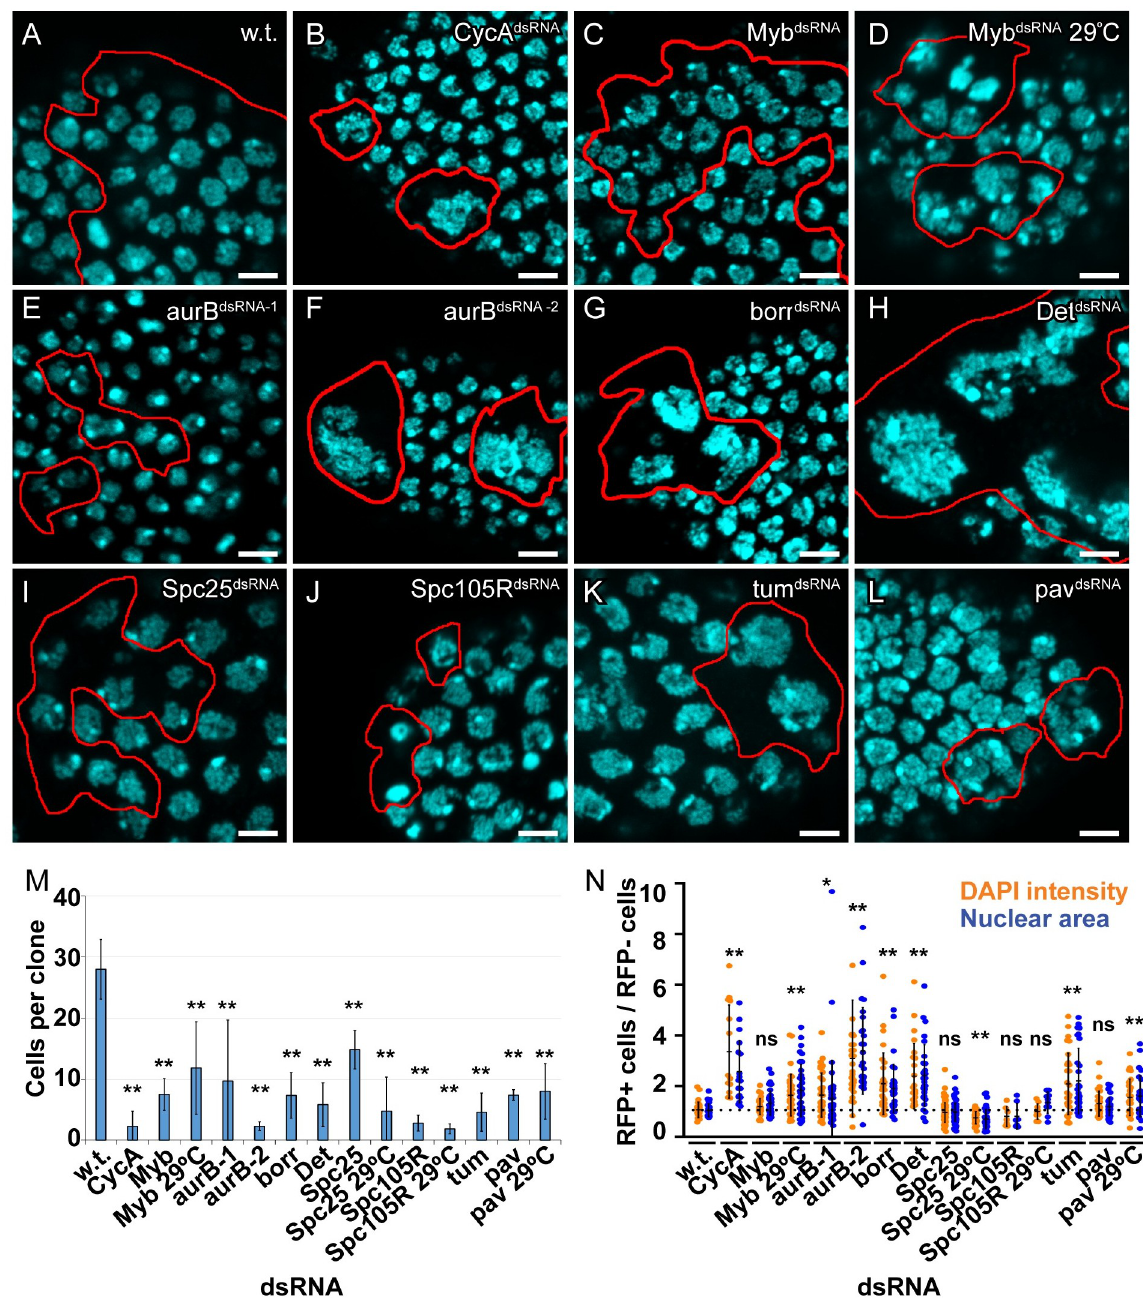
Fig 6. Knockdown of a CycA—Myb—AurB network induces endoreplication in ovarian follicle cells. (A-L) Clonal knockdown in follicle cells. FLP-On of GAL4 expression was induced by heat treatment of adult females of genotype hsp70-FLP , Act > cd2 > Gal4 , UAS-mRFP and the indicated UAS-dsRNA . mRFP positive clones were analyzed in stage 6 egg chambers three days later by labeling with DAPI and measuring nuclear size and total fluorescence intensity (DNA content). Red outlines in A-L indicate clone boundaries. (M) Quantification of number of cells per clone. RFP expressing cells were counted from at least four independent clones. More clones were counted in samples with fewer cells / clone (mean and S.D. for N � 4 clones, �� —p < 0.01 relative to wild type control clones). (N) Quantification of nuclear area and DAPI intensity. The nuclear area (blue dots) and DAPI intensity (orange dots) of single cells in a clone (RFP+) were measured and divided by the mean nuclear area and DAPI intensity of wild type cells (RFP-) in the same egg chamber (mean and S.D. for N � 3 clones, � —p < 0.05, �� —p < 0.01, ns—not significant relative to wild type, control